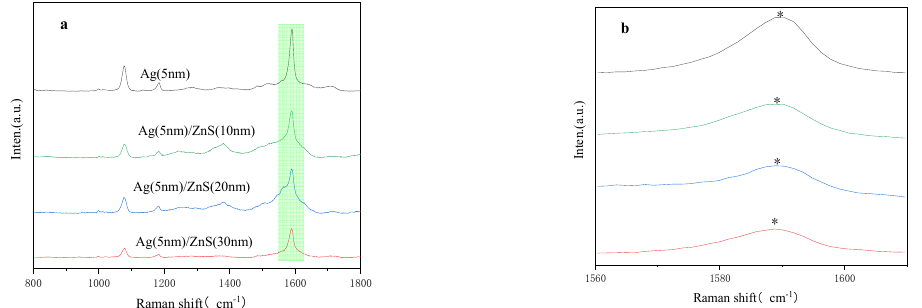
Figure 6. SERS observation of 4–MBA linked to the substrate Ag/ZnS (0–15 min) films on a PS bead array with different ZnS thicknesses ( a ). The magnification image shows the shift of the peak around 1588 cm − 1 when the ZnS thickness changes, which is labelled by the star ( b ).